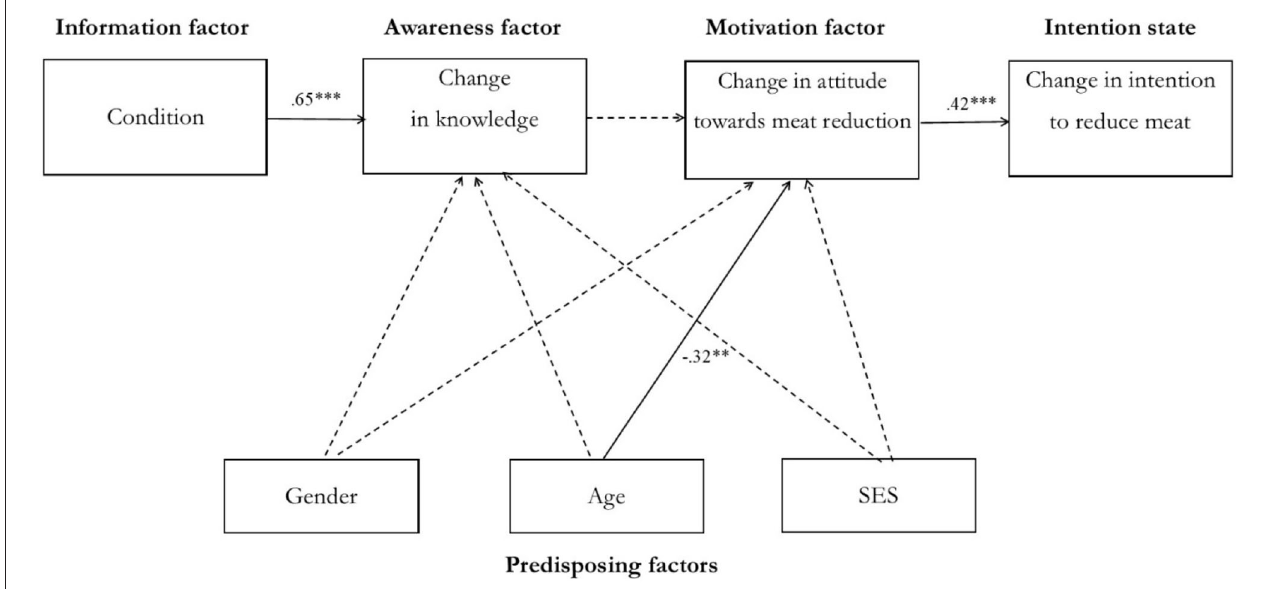
FIGURE 1 | Path model with significant standardized beta coefficients. *** p < 0.001, ** p <